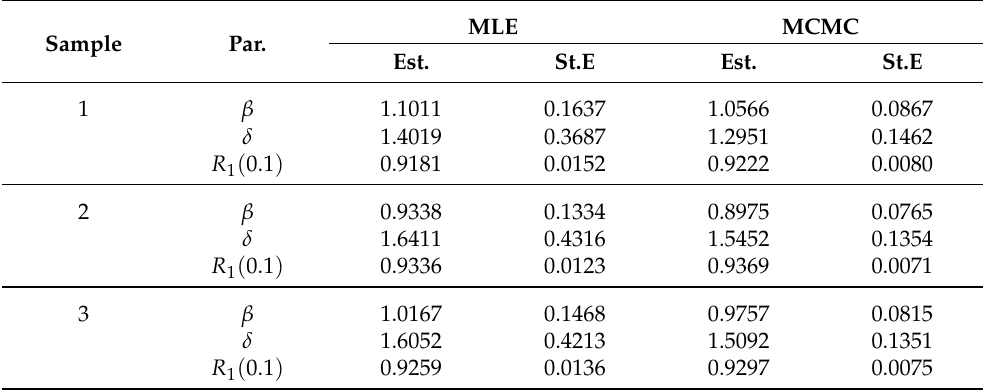
Table 9. Point estimates of β , δ and R 1 ( t ) from LED